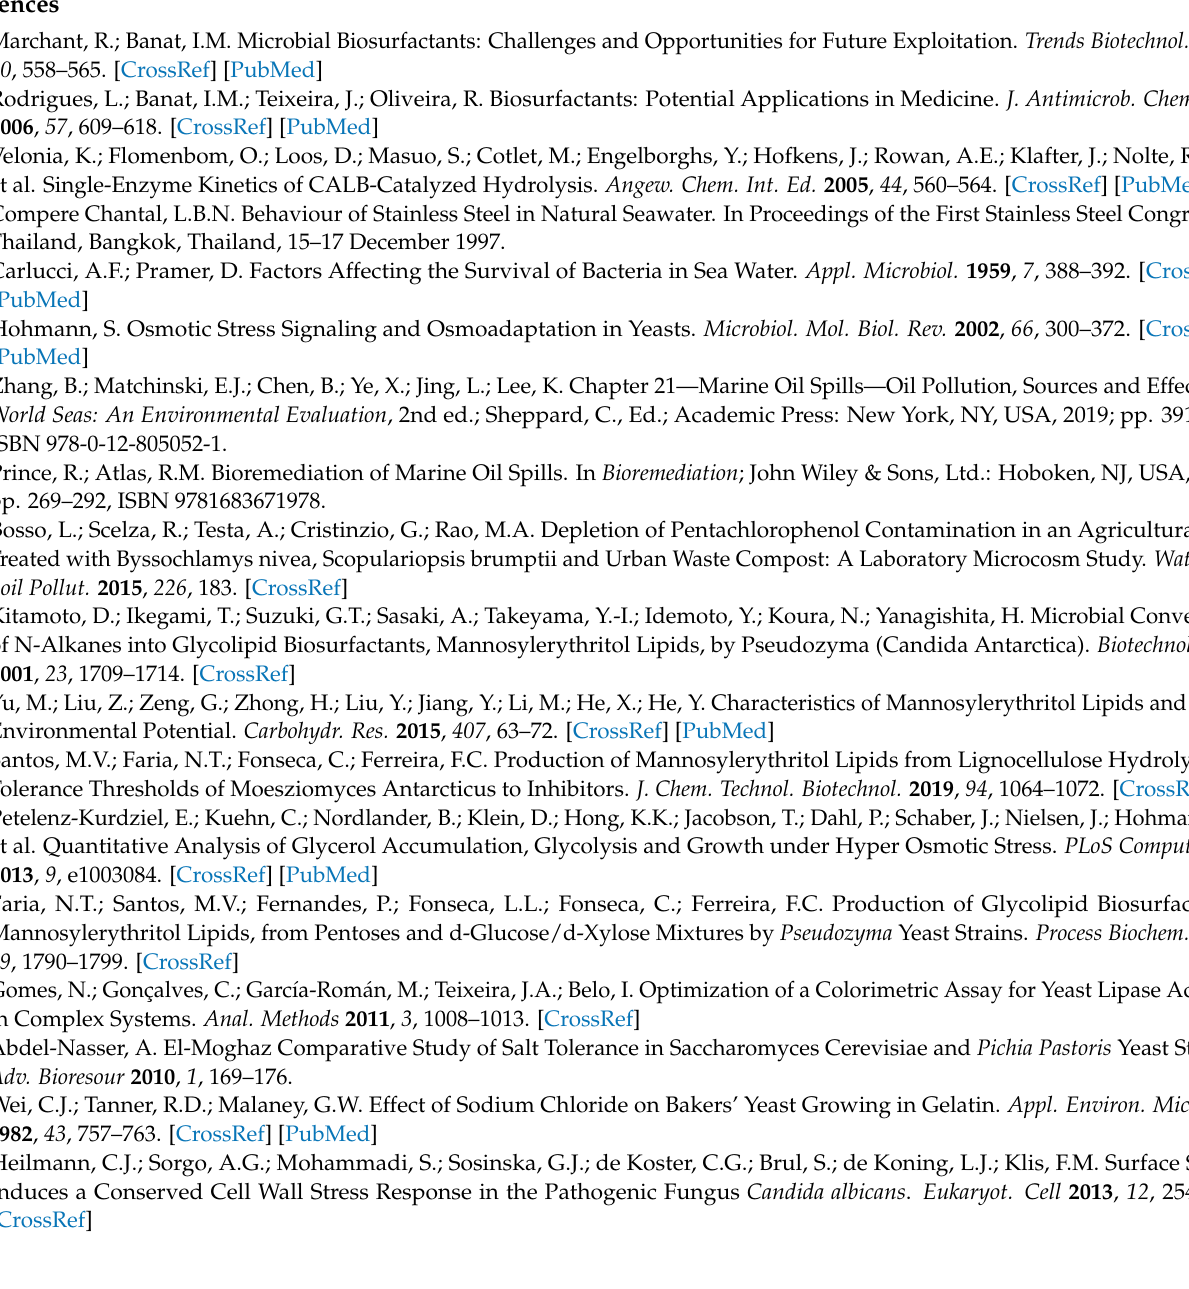
Figure A1. Profiles of relevant parameters in flasks containing various concentrations of NaCl: biomass; extracellular protein; lipase activity; lipase specific activity; free fatty acids; MELs (concentration of MELs calculated based on samples obtained) .